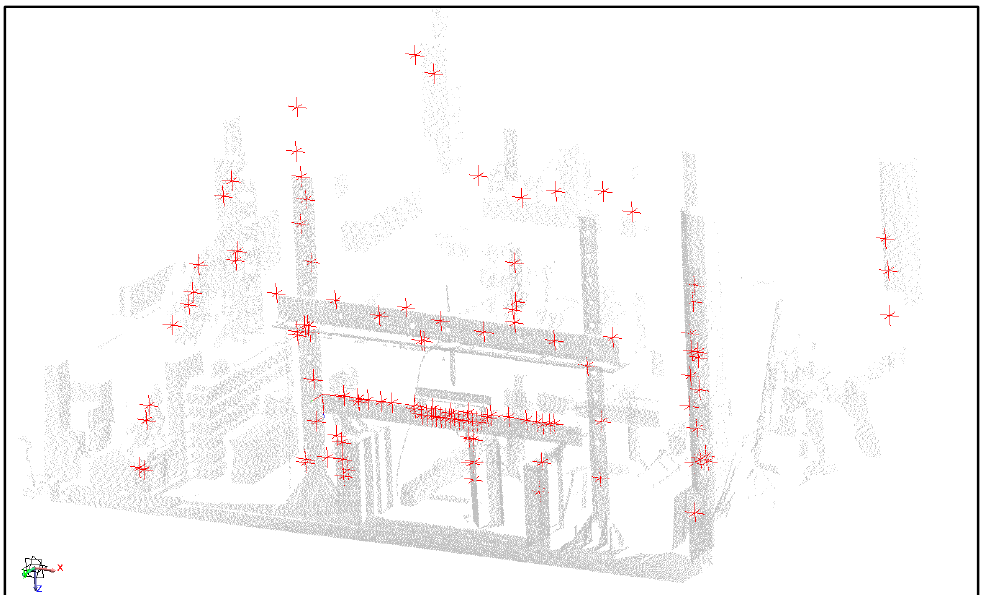
Figure 5. Spatial distribution of the targets in the test area.